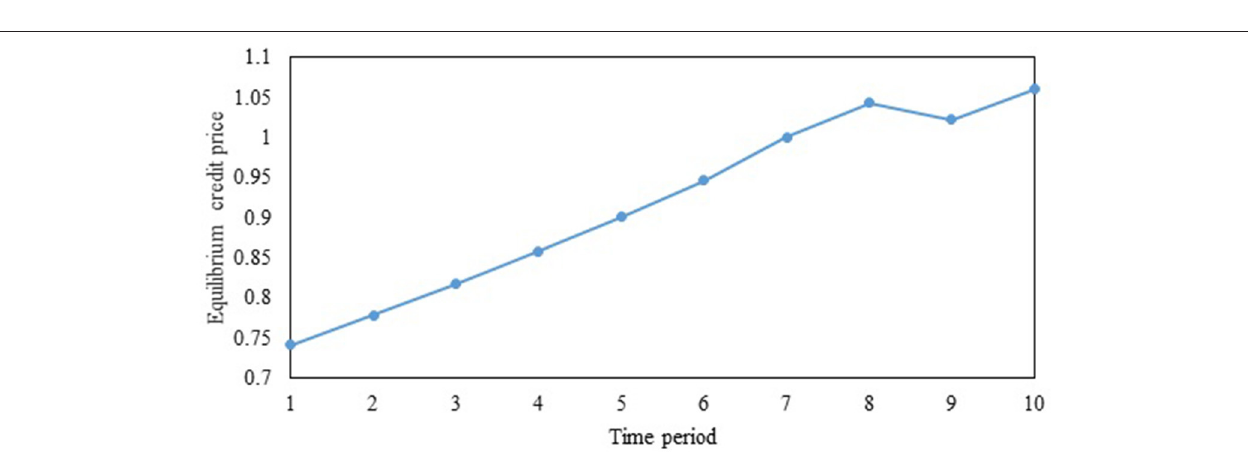
FIGURE 12 | Equilibrium credit prices under the system optimal multi-period TCS